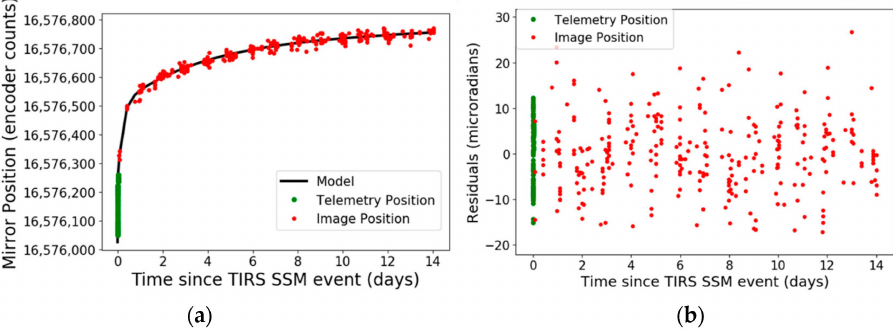
Figure 8. ( a ) The SSM mirror model for an event along with the encoder telemetry and calibration site measurements used in that model fit. The y -axis is in units of encoder counts; the x -axis is days from the start of the event. ( b ) The residuals of the fit from the model displayed in ( a ) with respect to the encoder telemetry and calibration site measurements used in the fit. The y -axis is in units of microradians; the x -axis is days from the start of the event. Encoder telemetry is shown as green dots, while the calibration site measurements are shown as red